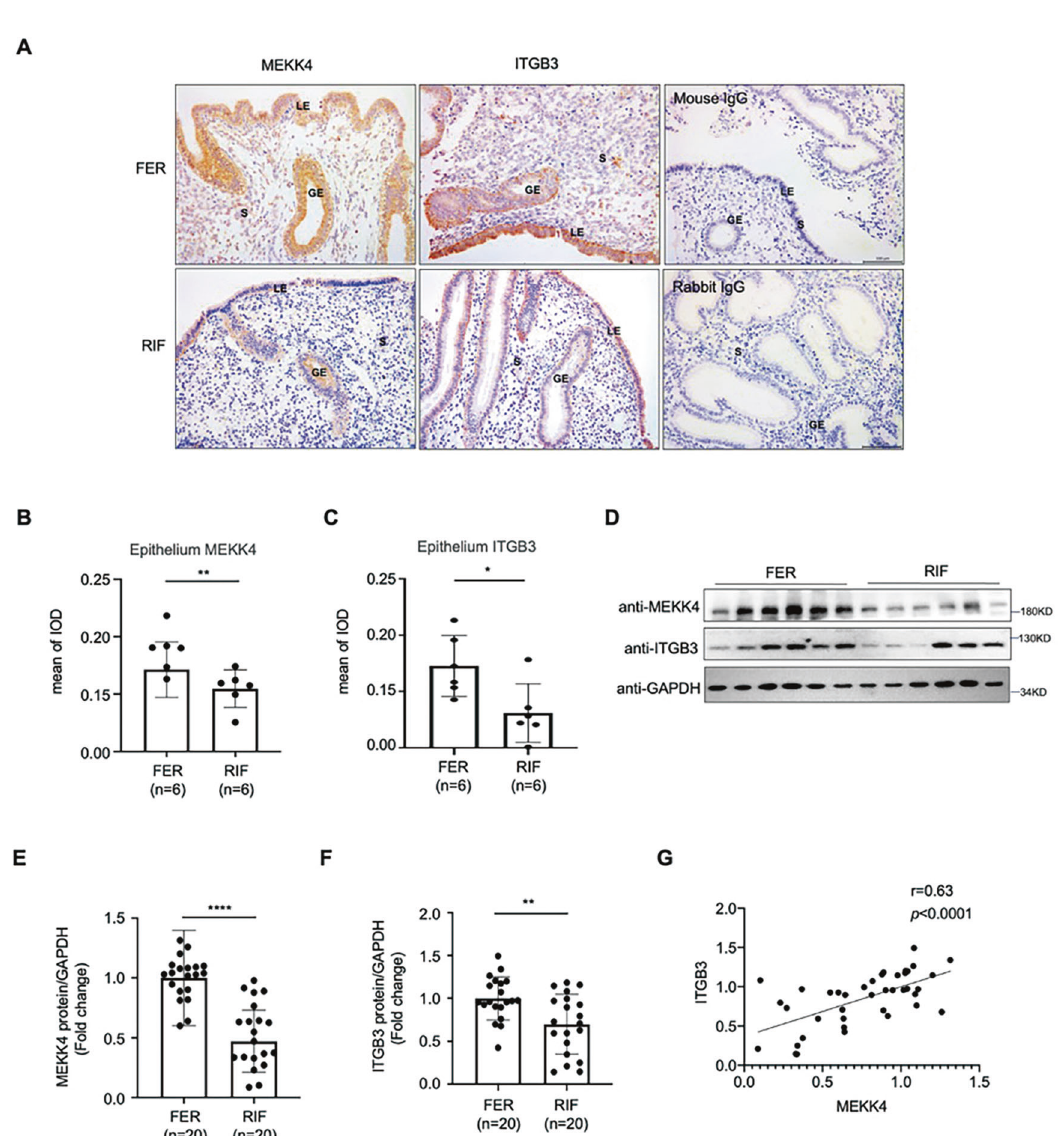
Fig. 6 Aberrant low expression of MEKK4 in the endometria of RIF patients. A – C Immunohistochemical analysis of the MEKK4 and ITGB3 expression in the endometrial epithelia of fertile women ( n = 6) and RIF patients ( n = 6). The negative controls (NC) were mouse IgG and rabbit IgG. (Scale bar = 100 µm, Data are represented as mean ± SEM, ** P < 0.01, * P < 0.05, using t -test). D – F Western blotting and quantitative densitometry analysis for MEKK4 and ITGB3 in the endometria of RIF patients ( n = 20) and controls ( n = 20). Data are represented as mean ± SEM, **** P < 0.0001; ** P < 0.01, using t -test. G Correlation between MEKK4 and ITGB3 protein expression in the endometria of RIF patients and the FER group ( r = 0.63, **** P < 0.0001, using simple linear regression and Pearson correlation coef fi cient).